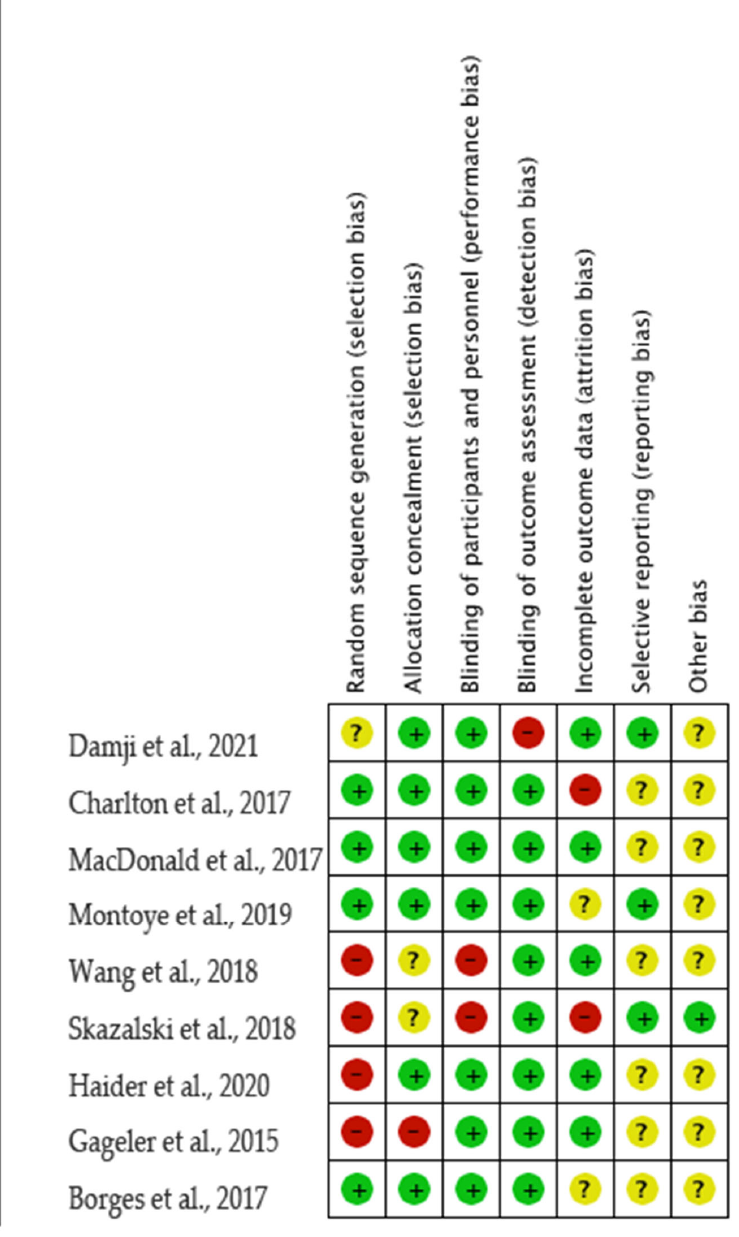
Figure 2. Judgments about each risk-of-bias item for each included study [8,17–24].